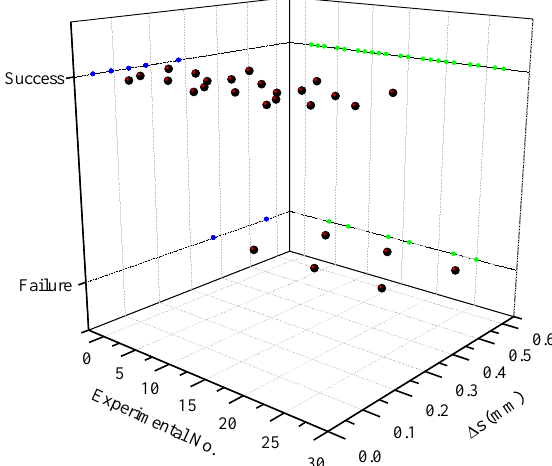
Figure 5. Synchronous rolling results under different compression amounts.